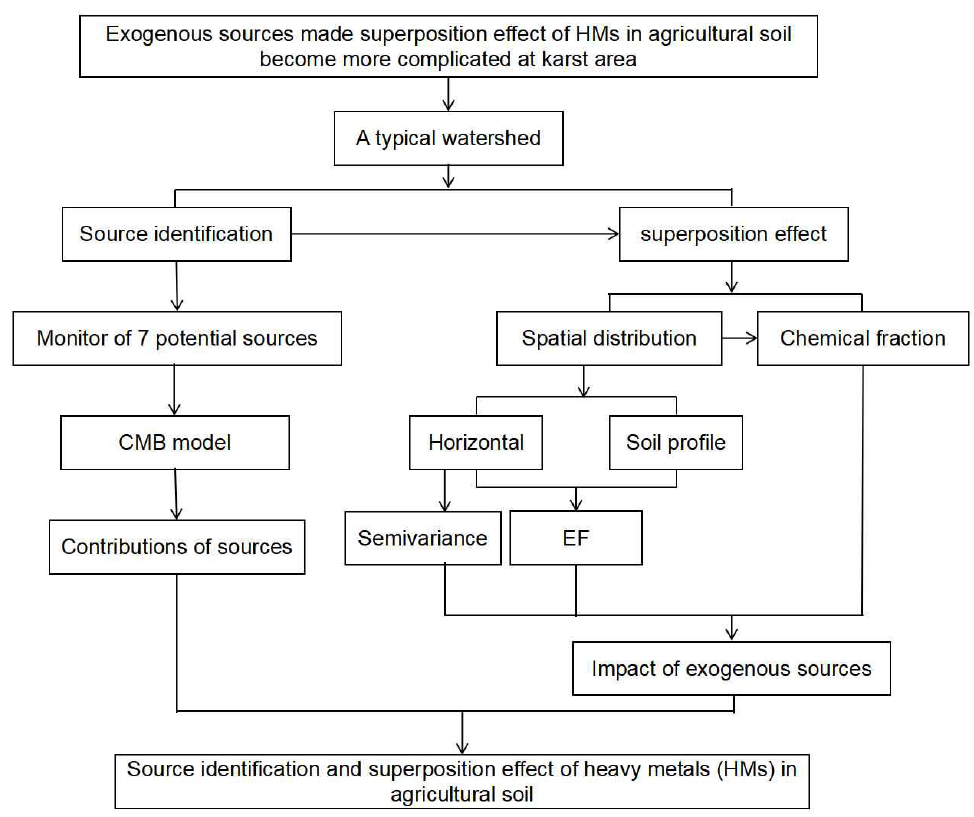
Figure 1. The framework for study of source identification and superposition effect of HMs.